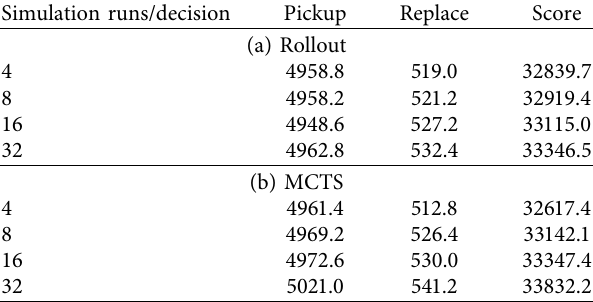
Table 4: Results under different simulation